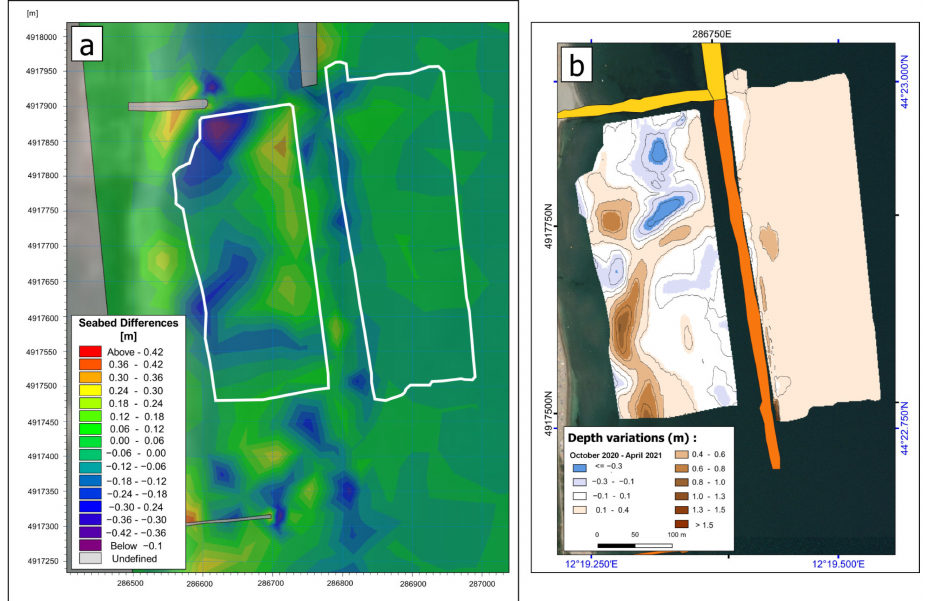
Figure 14. ( a ) Simulated seabed changes between October 2020 and April 2021. ( b ) Differential DTMs evaluated for the same